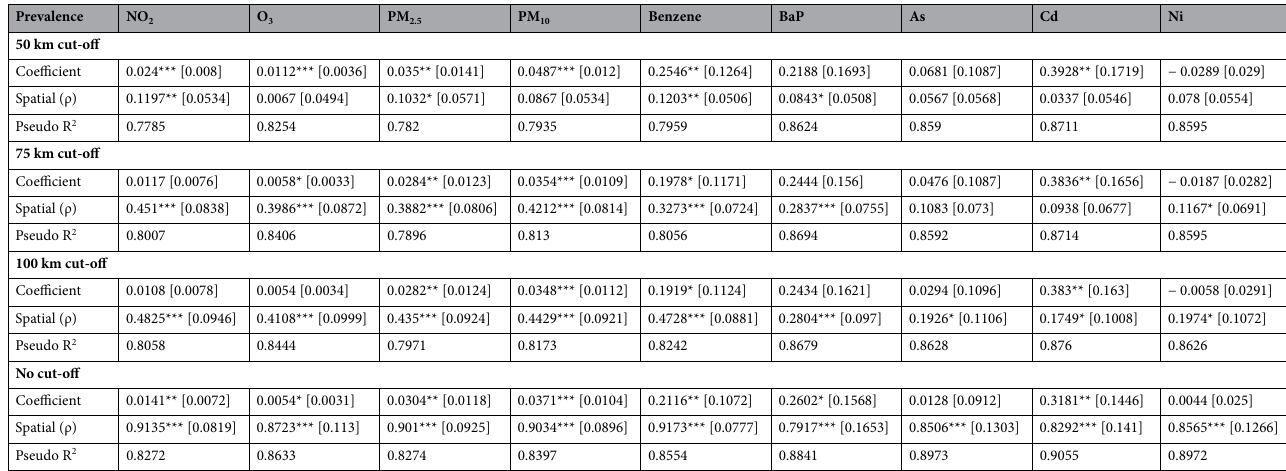
Table 11. Results from SAR models on COVID-19 prevalence rate registered on 30 November 2020. p-value < 0.01***; p-value < 0.05**; p-value < 0.1*. Standard errors in parentheses. All models included a constant and the following controls: dummies for regional capitals and national borders, size of the province, population aged 0–19, distance from nearest airport, share of foreigners, share of male population, population density, degree of urbanization, deaths due to LRT disease, smokers, obese individuals, large firms, altitude, and rainy days.